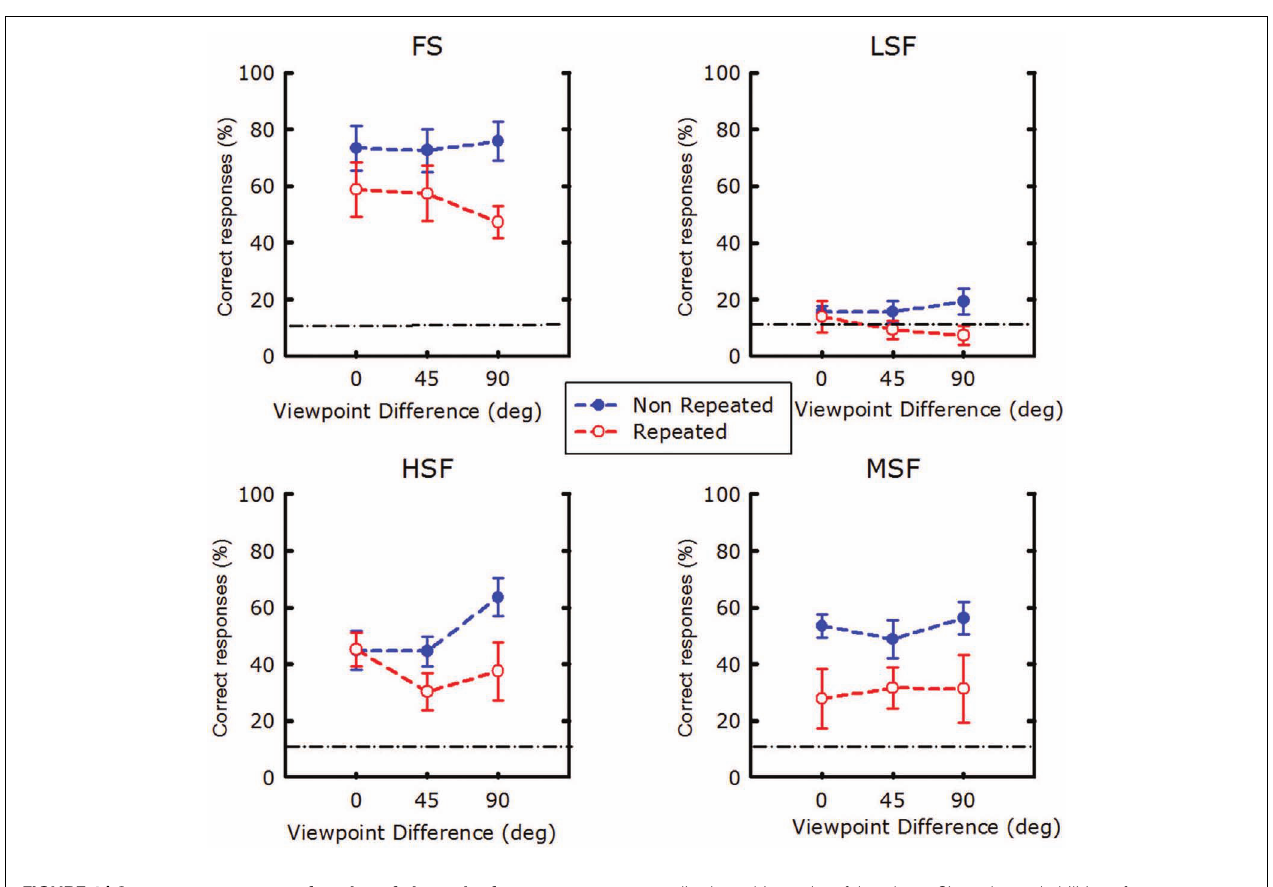
FIGURE 4 | Correct-responses as a function of viewpoint for each spatial frequency condition. Data for non-repeated conditions are shown in blue; data for repeated conditions are shown in red.The dark dash-dot line shows the chance level.The chance level in the experiment is the combined probability to be